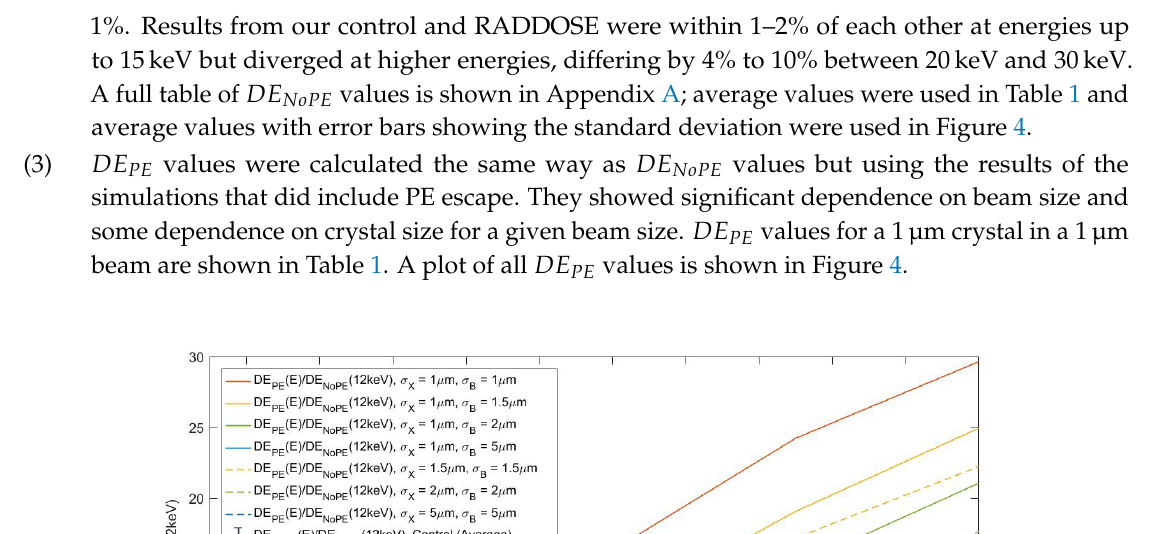
1 µm) at E = 12 keV, with the greatest difference occurring at 30 keV (7.15 ( σ X = σ B = 5 µm) and 29.64 ( σ X = σ B = 1